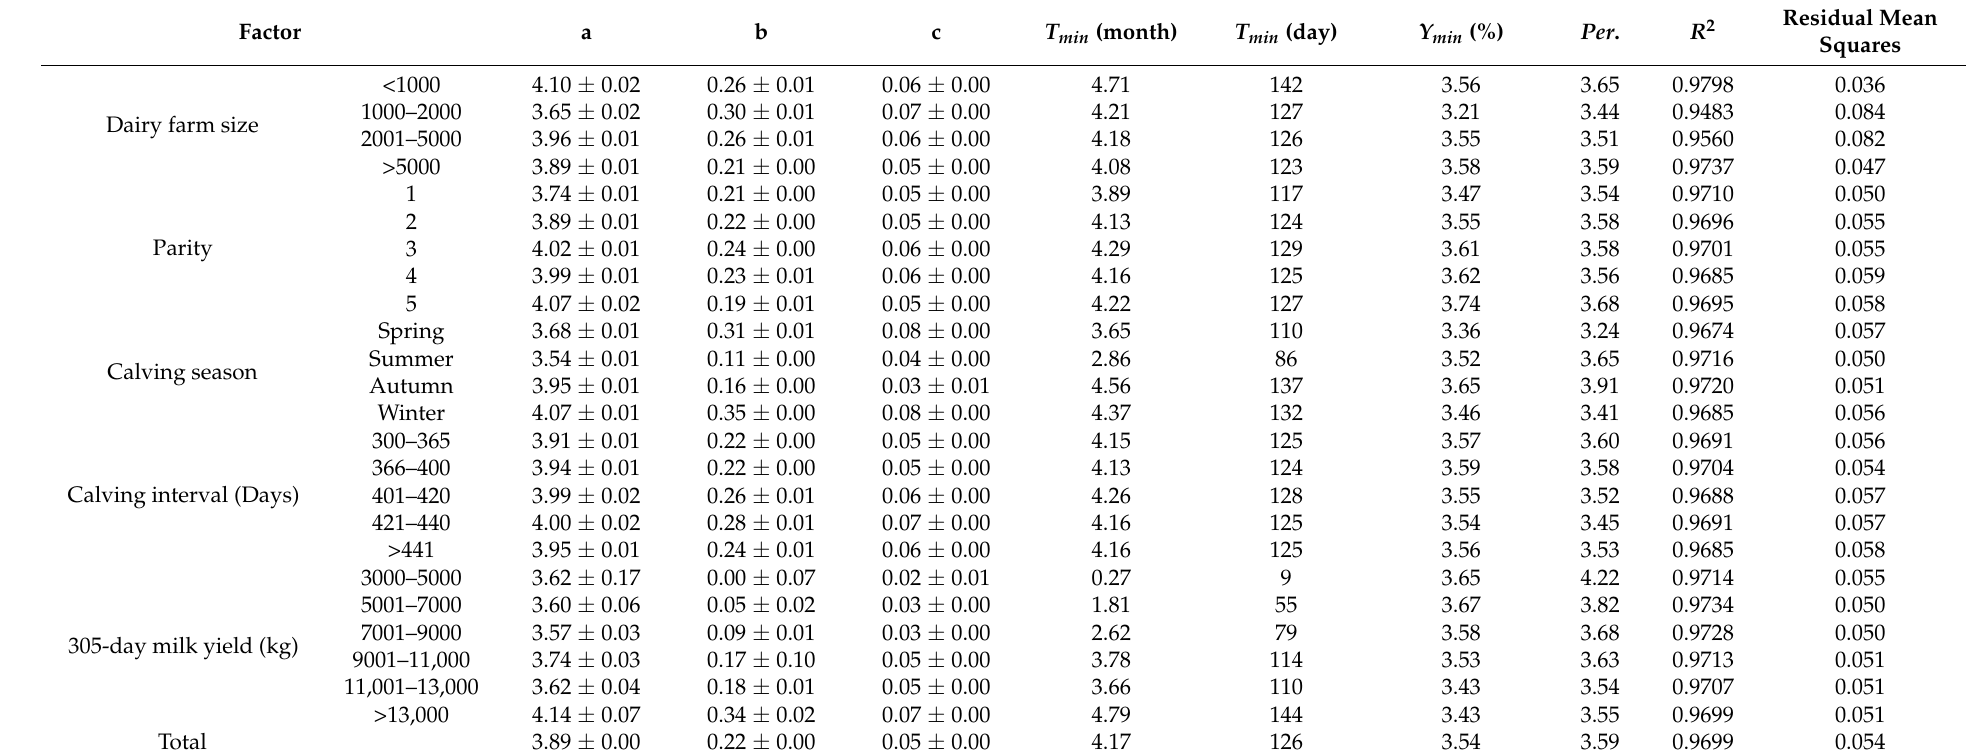
Table 4. Wood model fitting parameters of daily milk fat percentage by different